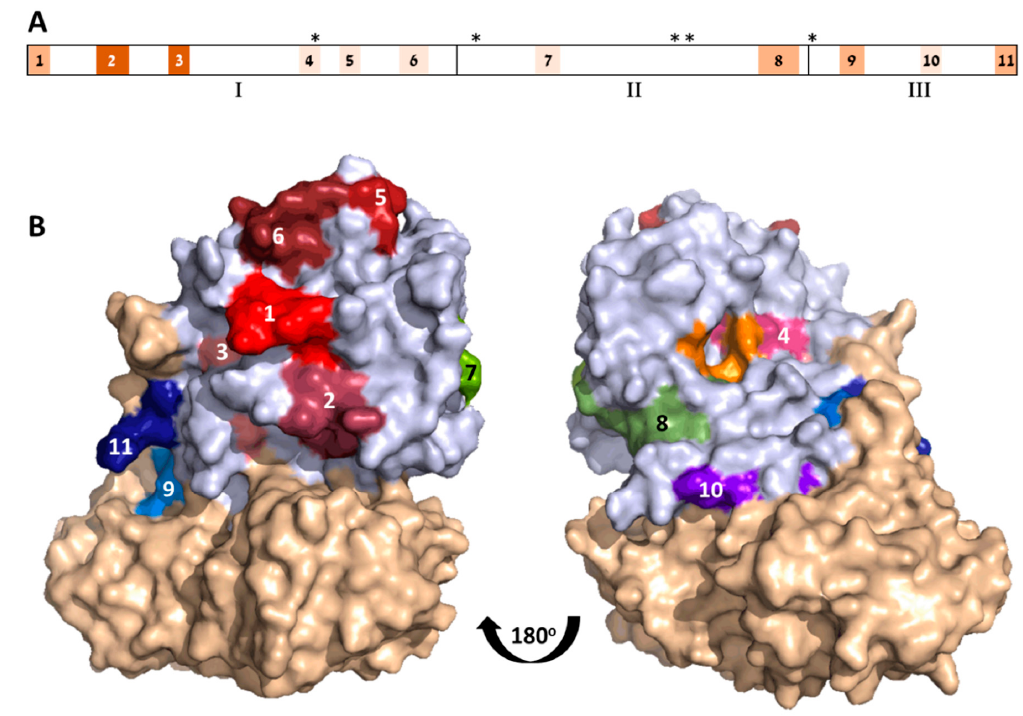
Figure 2. Immunodominant epitopes on ATA. ( A ) Linear depiction of ATA subunits folding domain (1–3) and amino acid residues (marked by asterisks) comprising catalytic domain. Location of immunodominant epitopes (1–11) marked as shaded boxes, whereas shading tones represent number of sera that reacted with each epitope (pale to darkest for 1 to 3 sera, respectively). ( B ) Crystal structure of abrin (PDB 1abr; ATA in pale blue and enzymatic B-chain (ATB) in light brown). Immunodominant epitopes color-coded and numbered; catalytic domain in orange.